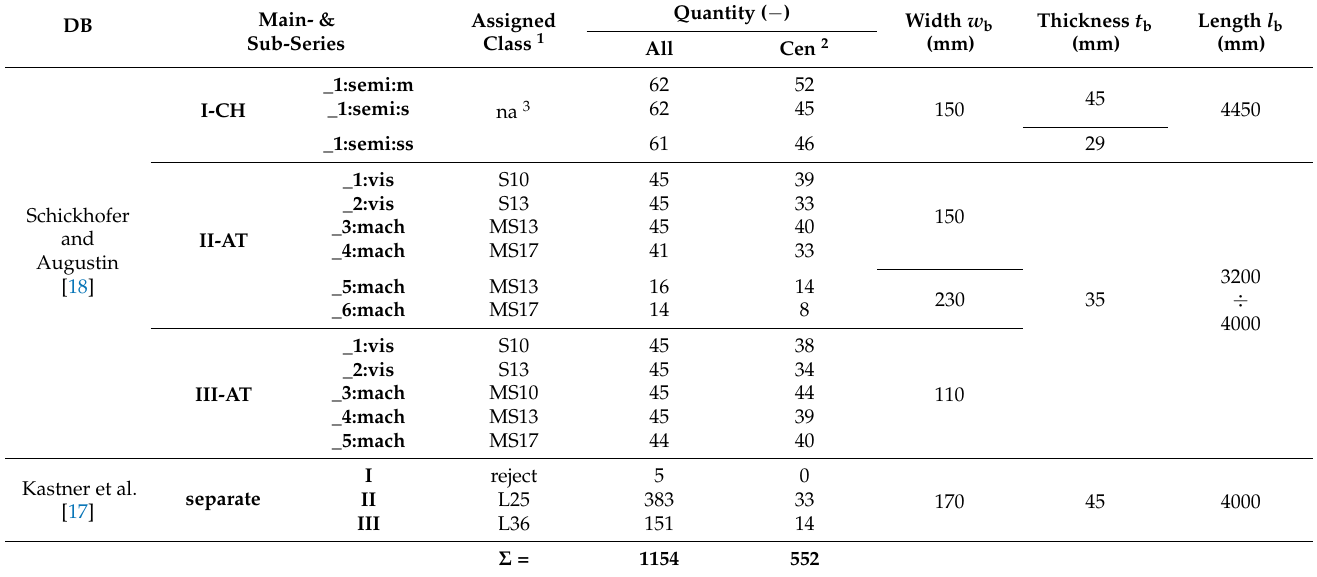
Table 2. Test data from two board databases: overview of main- and sub-series, nominal grading classes, quantities, and dimensions based on Schickhofer and Augustin [18] and Kastner et al.